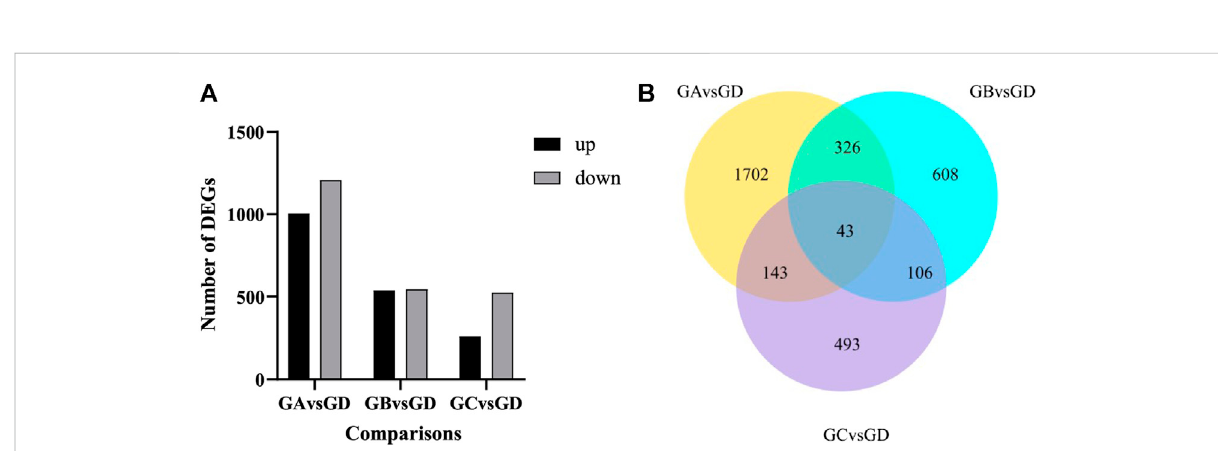
Effect of fl umethrin on gene expression of newly emerged honeybees. (A) Numbers of DEGs of A. mellifera larvae treated with fl umethrin. Up- and down-regulation indicates higher or lower expression of these genes in the treatment groups. (B) Venn analysis of DEGs. The sum of the numbers in each large circle represents the total number of DEGs in the comparative combinations, while the overlapping part of the circles represents the DEGs shared by the combinations. GA, GB, GC, and GD represent 1, 0.1, 0.01, and 0 mg/L groups,